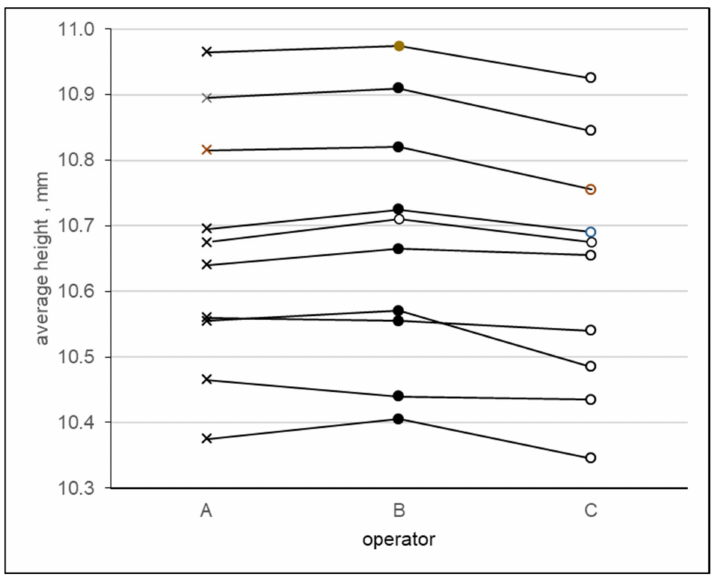
Figure 8. Interaction